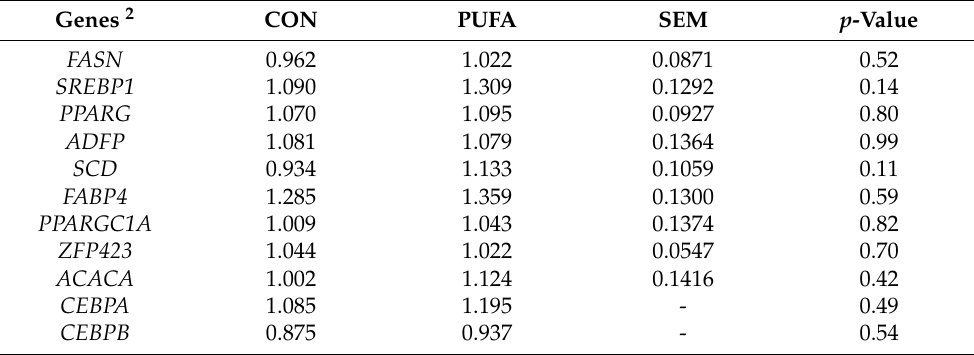
Table 7. Relative mRNA expression of genes regulating adipogenesis in subcutaneous adipose of the steer progeny born from cows supplemented either 155 g DM/d EnerGII (CON) or 80 g DM/d Strata + 80 g DM/d Prequel (PUFA) for the last 77 ± 6 d of gestation 1. Genes 2 CON PUFA